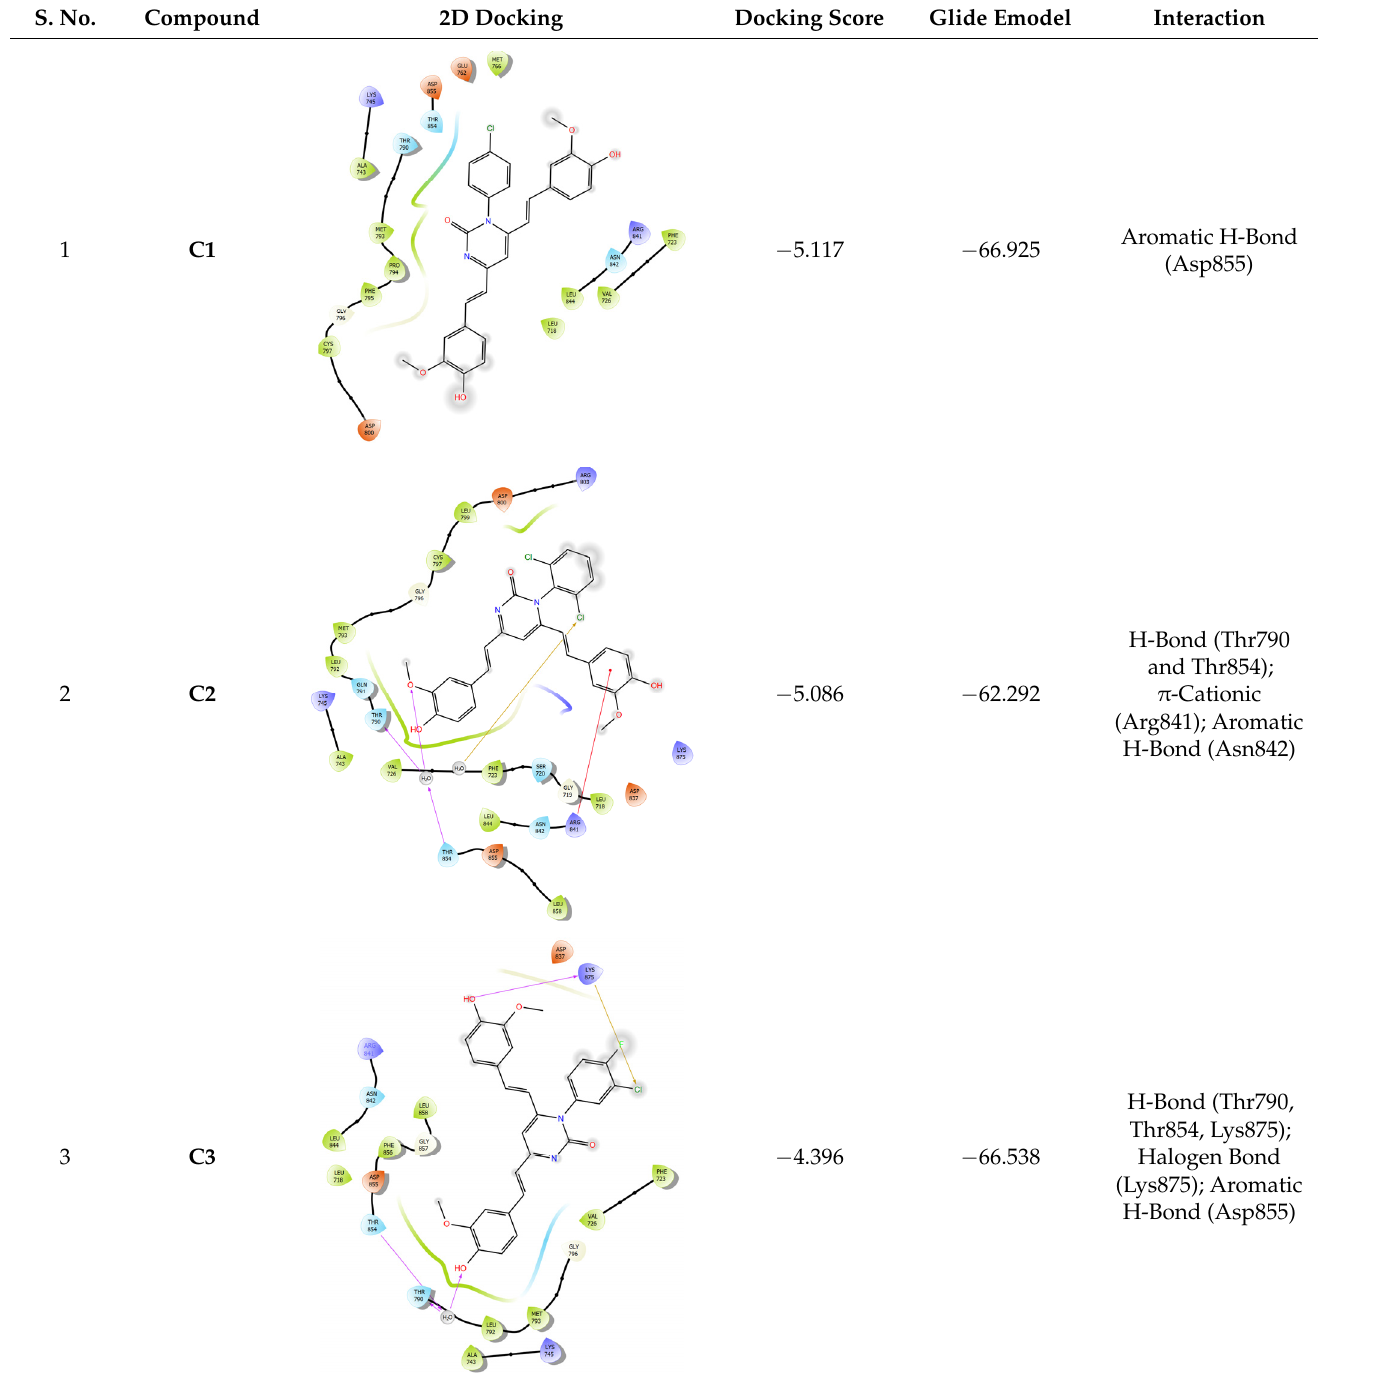
Table 3. The molecular docking results of curcumin analogues against EGFR.